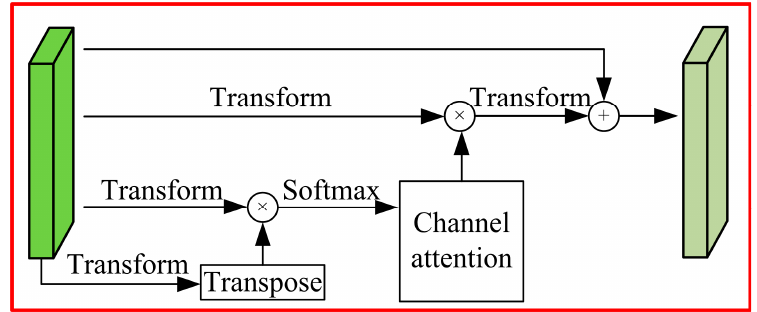
Figure 4. Channel attention model.